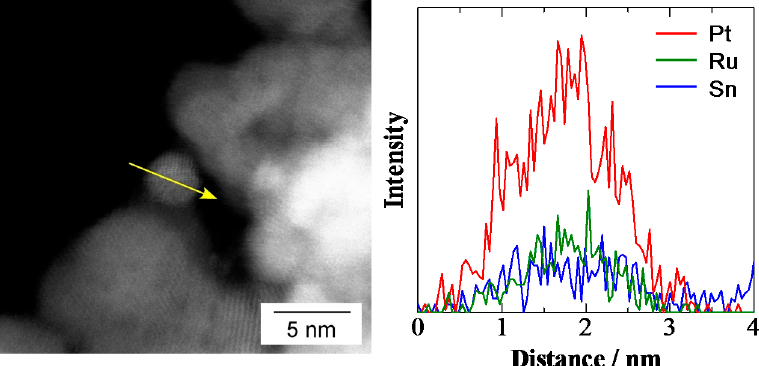
Figure 8. High-angle annular dark-field (HAADF)-STEM (transmission microscope) images and Figure 8. High ‐ angle annular dark ‐ field ( HAADF) ‐ STEM (transmission microscope) images and elemental distributions of Pt, Ru, and Sn obtained by EDX (dispersive X-ray) line scan analysis parallel elemental distributions of Pt, Ru, and Sn obtained by EDX (dispersive X ‐ ray) line scan analysis parallel to the interface between the PtRu catalyst metal particles and the Sb-SnO 2 to the interface between the PtRu catalyst metal particles and the Sb ‐ SnO 2 support.